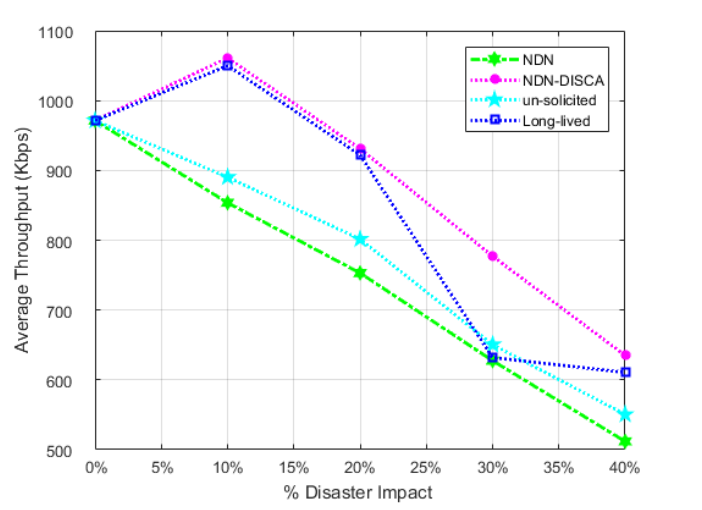
Figure 10. Average Throughput w.r.t Fire Disaster Affected SL-2 in